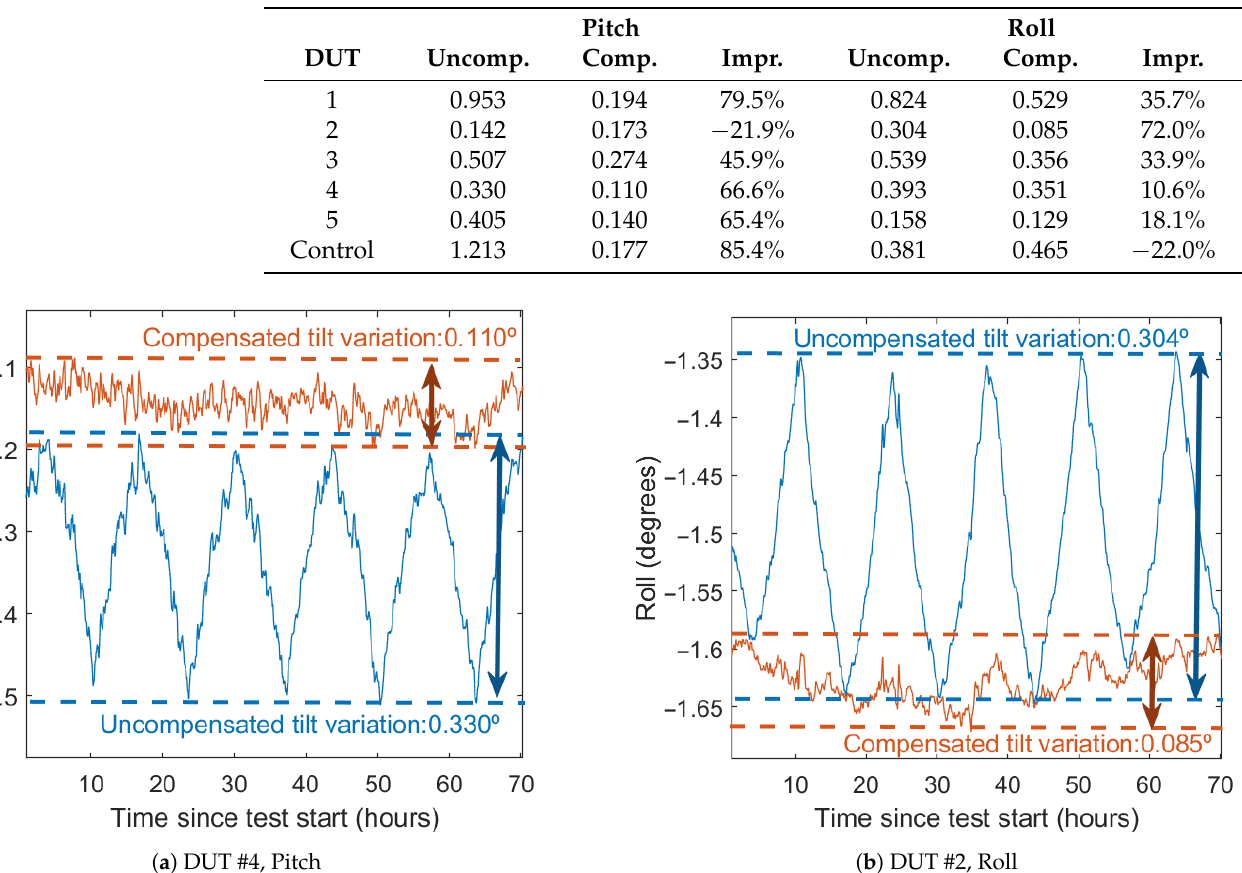
Figure 14. Euler angles before and after